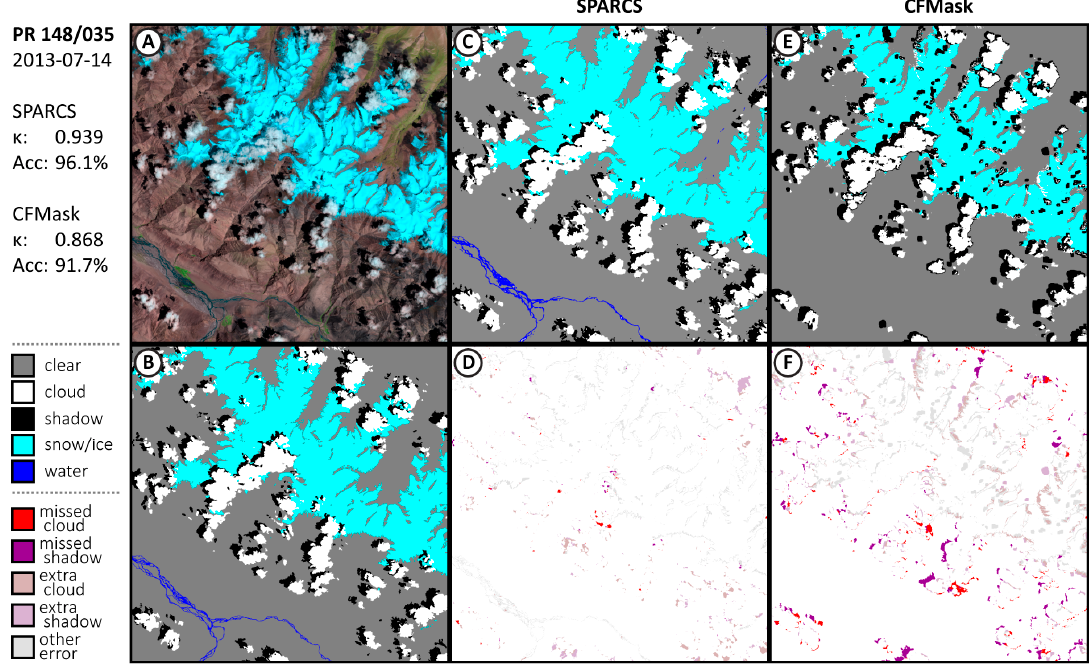
Figure 4. Results over test images at path / row 148 / 035 showing false color image used during interpreation ( A ), the manually labeled interpretation ( B ), with generated masks from SPARCS ( C ) and CFMask (E) with respective spatial distribution of errors ( D , F